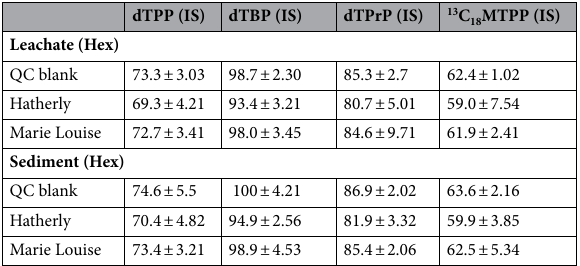
Table 3. Mean (n = 2) spiked surrogate percentage recoveries ± standard deviations (SD) of real and blank leachate and sediment samples using hexane for extraction.